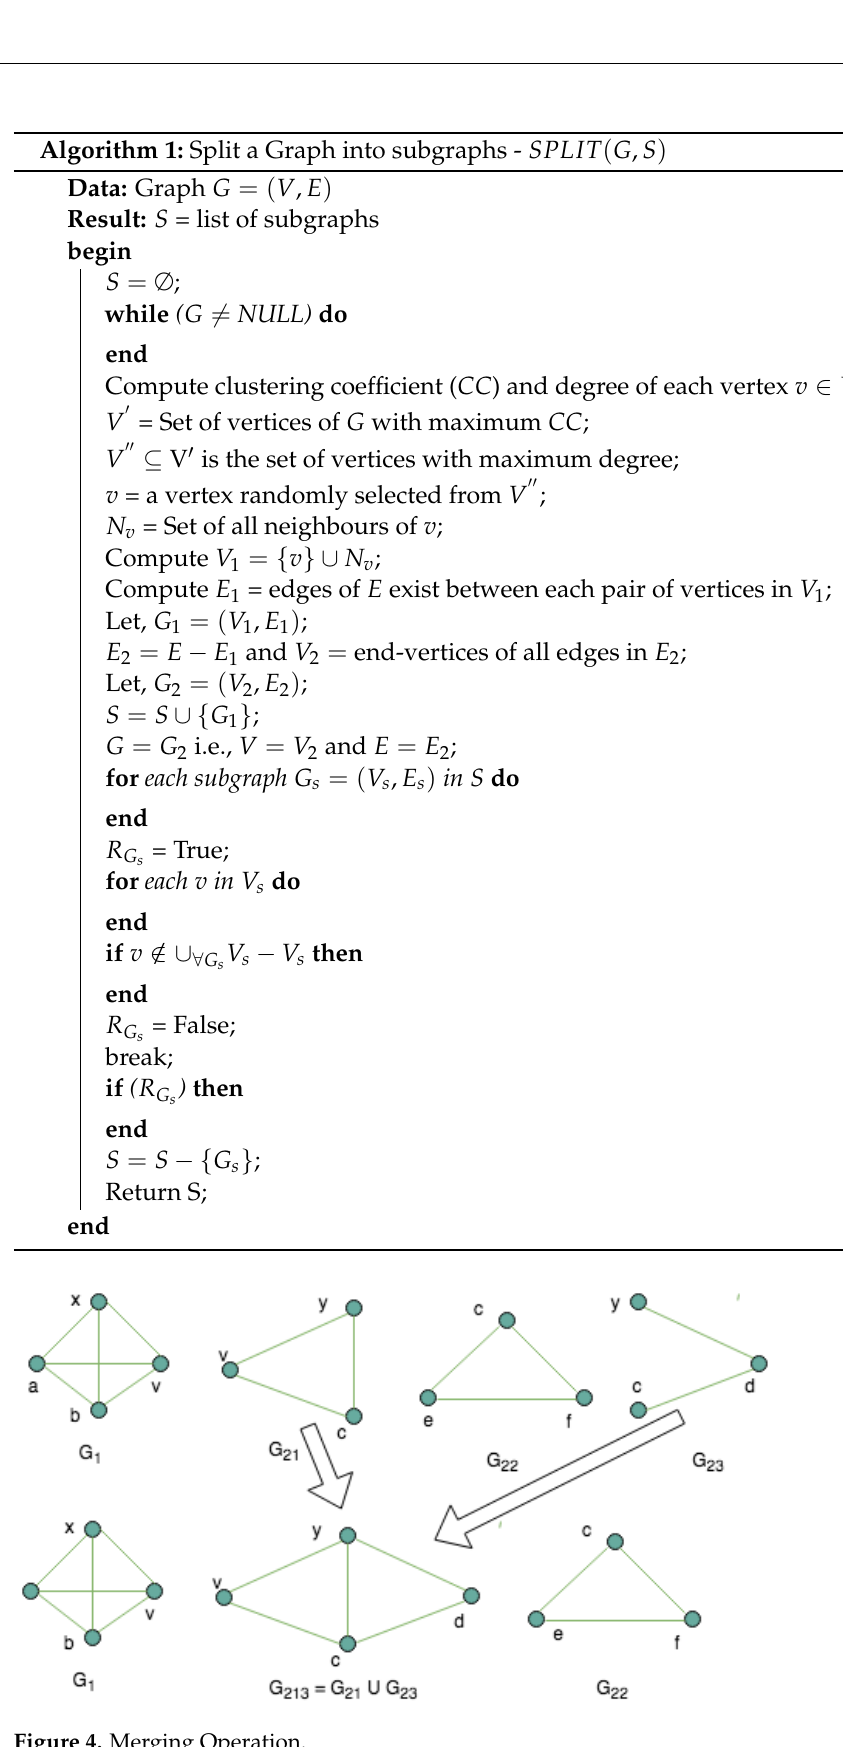
Figure 4. Merging